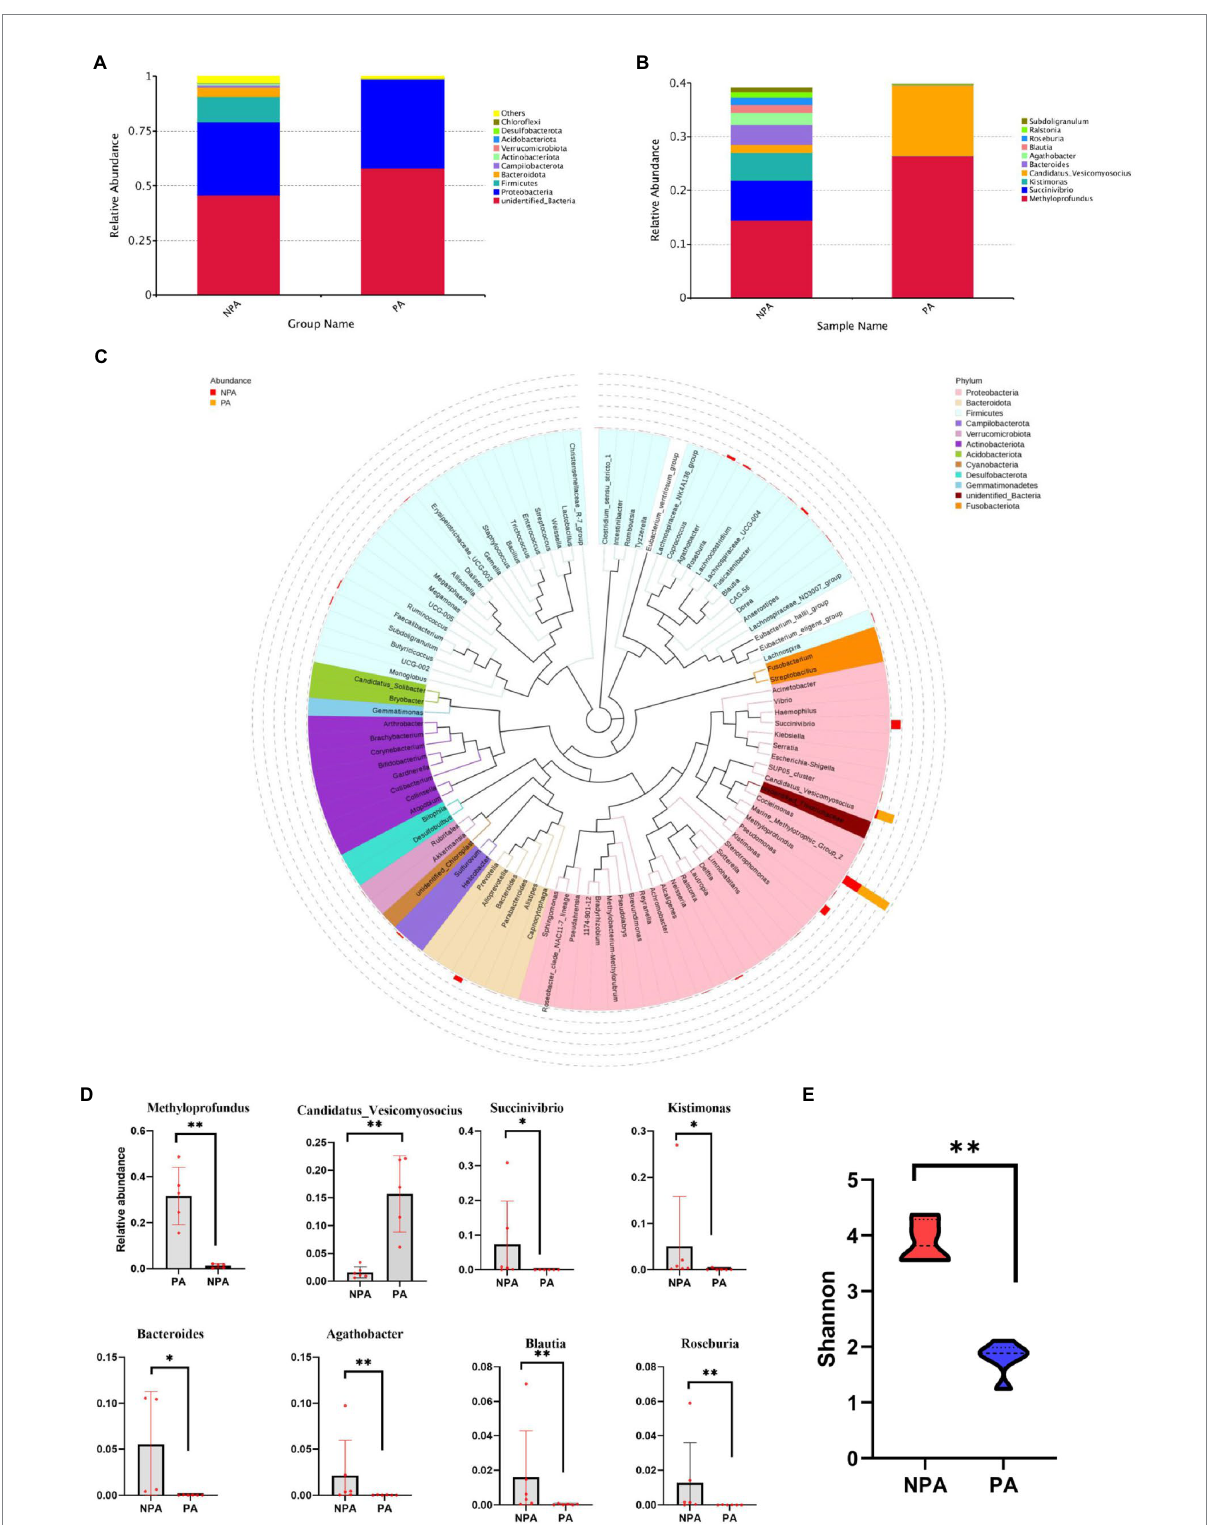
FIGURE 2 Microbial community structure and diversity between NAP and PA. (A) Relative bacterial abundance at phylum level in NA and NPA. (B) The all microbial community structure in PA and NPA at genus level. (C) Comparison of relative abundance at top 10 genus level between groups PA and NPA. (D) Statistical analysis showing the most significant changes between groups PA and NPA, *mean p < 0.05 and **mean p < 0.01. (E) The Shannon diversity in NPA and